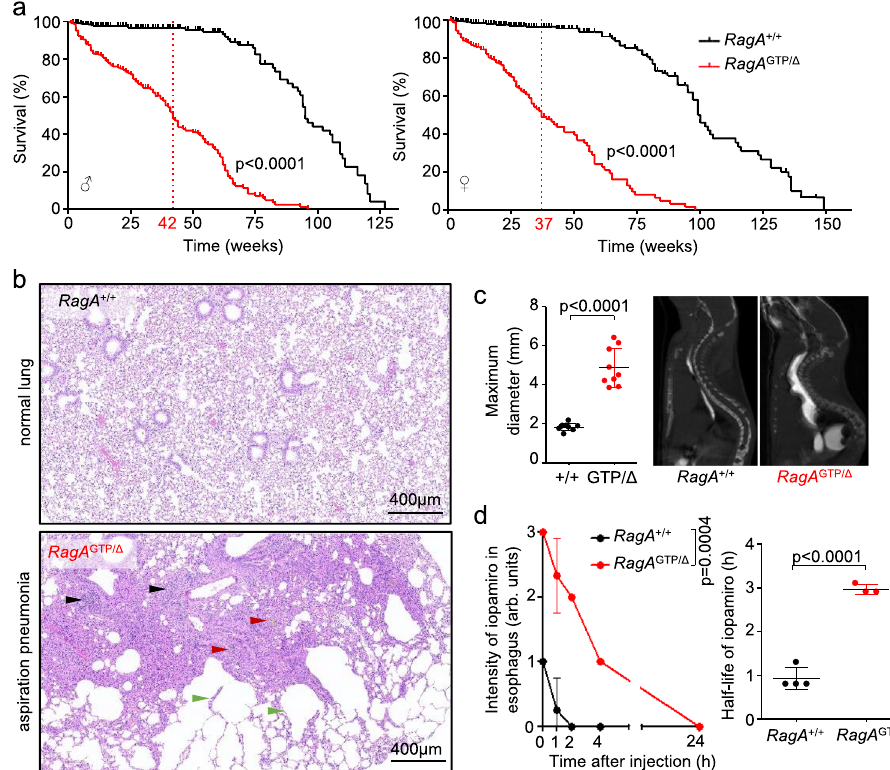
Fig. 2 Premature death of RagA GTP/ Δ mice. a Kaplan-Meier survival curves of RagA + / + and RagA GTP/ Δ males ( n = 503 and n = 235) and females ( n = 521 and n = 220). Mean survival depicted in red. Statistical signi fi cance was calculated with the log-rank (Mantel-Cox) test. b Representative H&E staining of a normal lung ( RagA + / + ) and a lung with areas of pneumonia ( RagA GTP/ Δ ), black arrowheads indicate in fi ltration of in fl ammatory cells, red arrowheads indicate the presence of macrophages with hemosiderin and green arrowheads indicate areas of emphysema. This phenotype was observed in at least 32 mutant mice. c (Left) Maximum esophageal diameter was measured upon sacri fi ce of RagA + / + ( n = 9) and RagA GTP/ Δ ( n = 9) mice. (Right) Representative CT image of an esophagus administered with an oral contrast (iopamiro). Statistical signi fi cance was calculated by using unpaired two- tailed t-test. d Quanti fi cation of remnant iopamiro in the esophagus following its administration in RagA + / + ( n = 4) and RagA GTP/ Δ ( n = 3) mice. Half-life of iopamiro was calculated from the slope of each individual curves and analyzed by using an unpaired two-tailed t-test. For the intensity of iopamiro, statistical signi fi cance was calculated by using 2-way ANOVA (mixed-effects model RELM). In all panels, horizontal lines indicate the mean and error bars depict Standard deviation